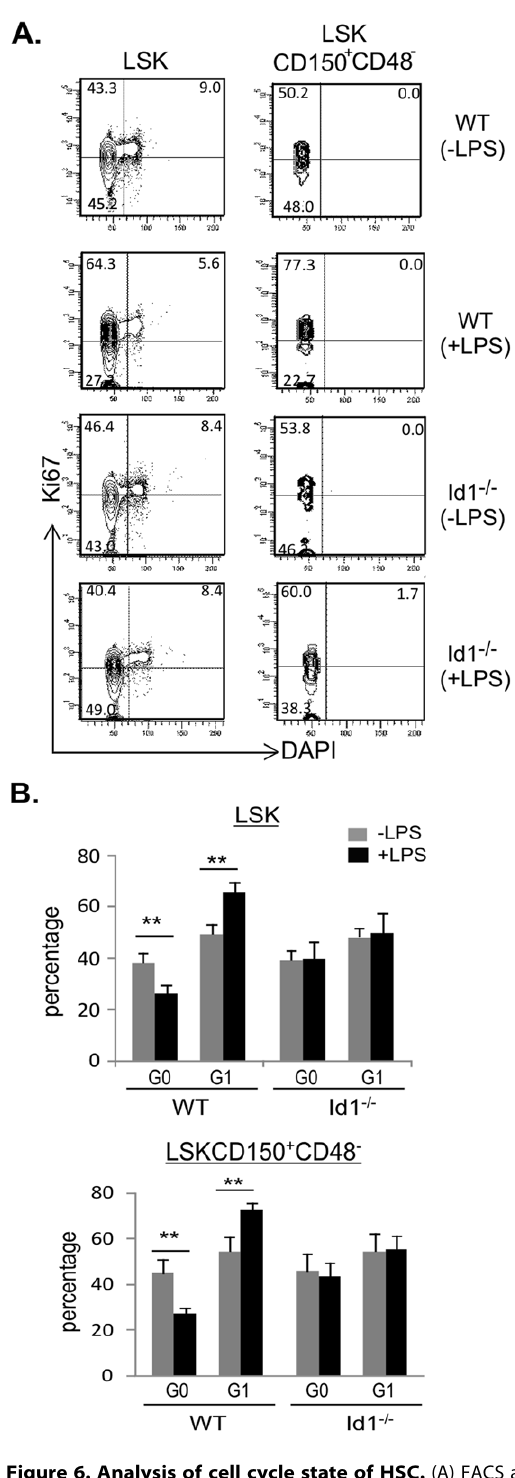
Figure 6. Analysis of cell cycle state of HSC. (A) FACS analysis for expression of Ki67 in indicated subsets were performed by intracellular staining followed by DAPI staining for DNA content. Ki67 positive gate for each sample was set based on the level of Ki67 in cycling cells identified according to DAPI intensity of cells in the LSK population. Numbers indicate the percentage in each quadrant. (B) Average percentages of cells in G0 and G1 phases are shown with SD. Grey bar, untreated; black bar, treated with 1 m g of LPS for 30 days. ** p , 0.01.